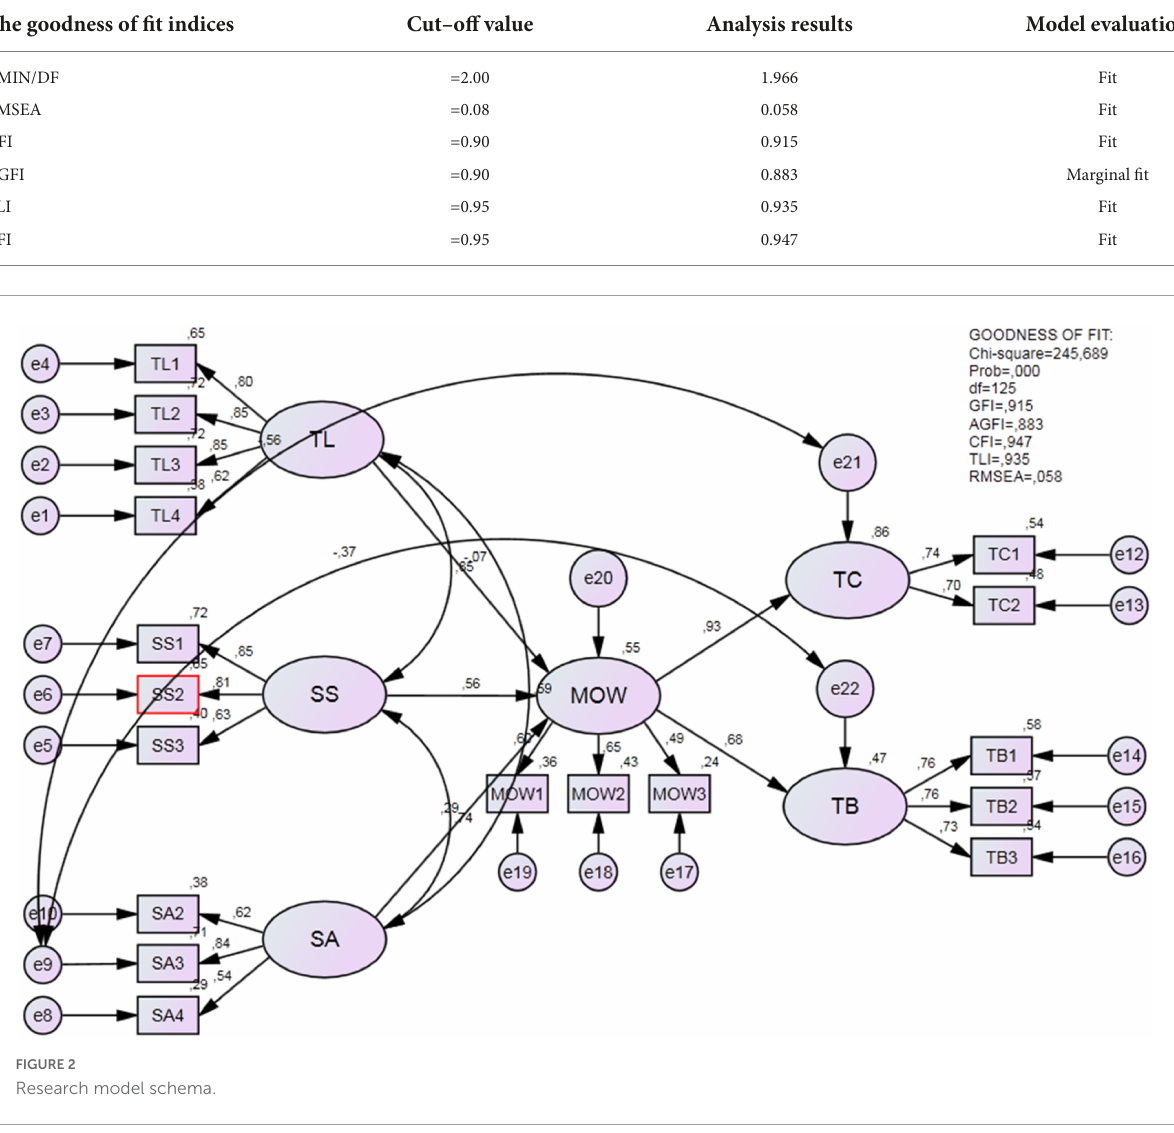
FIGURE2 Research model schema.